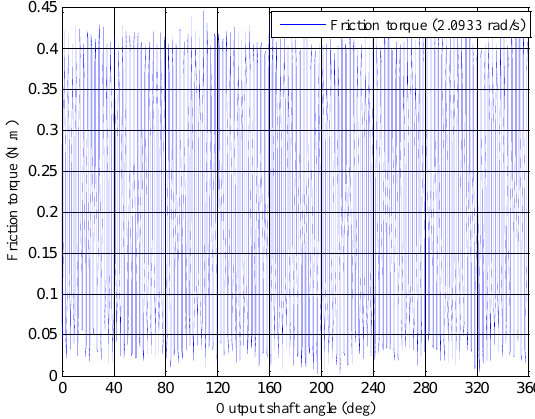
Figure 5. Friction torque of a RV reducer (2.0933 rad/s).